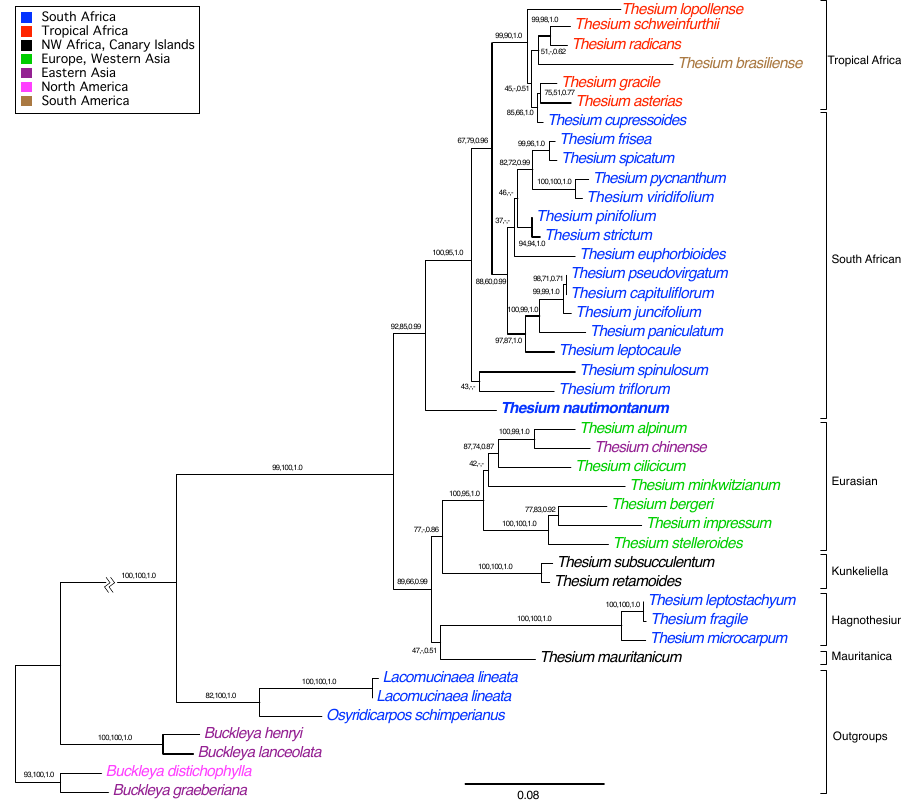
Figure 4. Phylogram for Thesiaceae that includes Thesium nautimontanum sp. nov. (bold). Values at the nodes indicate maximum likelihood bootstrap, maximum parsimony bootstrap and Bayesian posterior probabilities. The scale bar represents number of substitutions per site. Branch lengths are proportional to the amount of substitutional change, except for the branch connecting the outgroup to the ingroup (here shorted for graphical purposes). Group (clade) names are from Nickrent and García (2015) . The colour coding for the taxa indicates the general geographic distribution for the species as shown in the